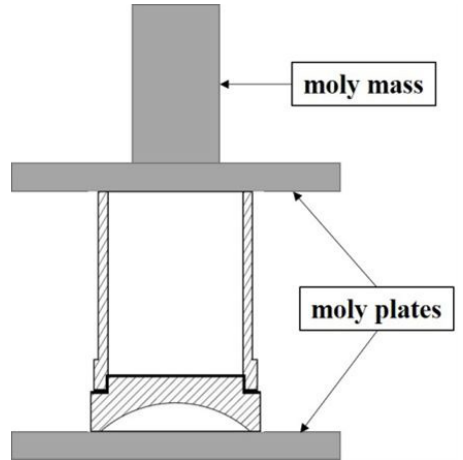
Figure 5. Schematic jig drawing for hydrogen brazing process.